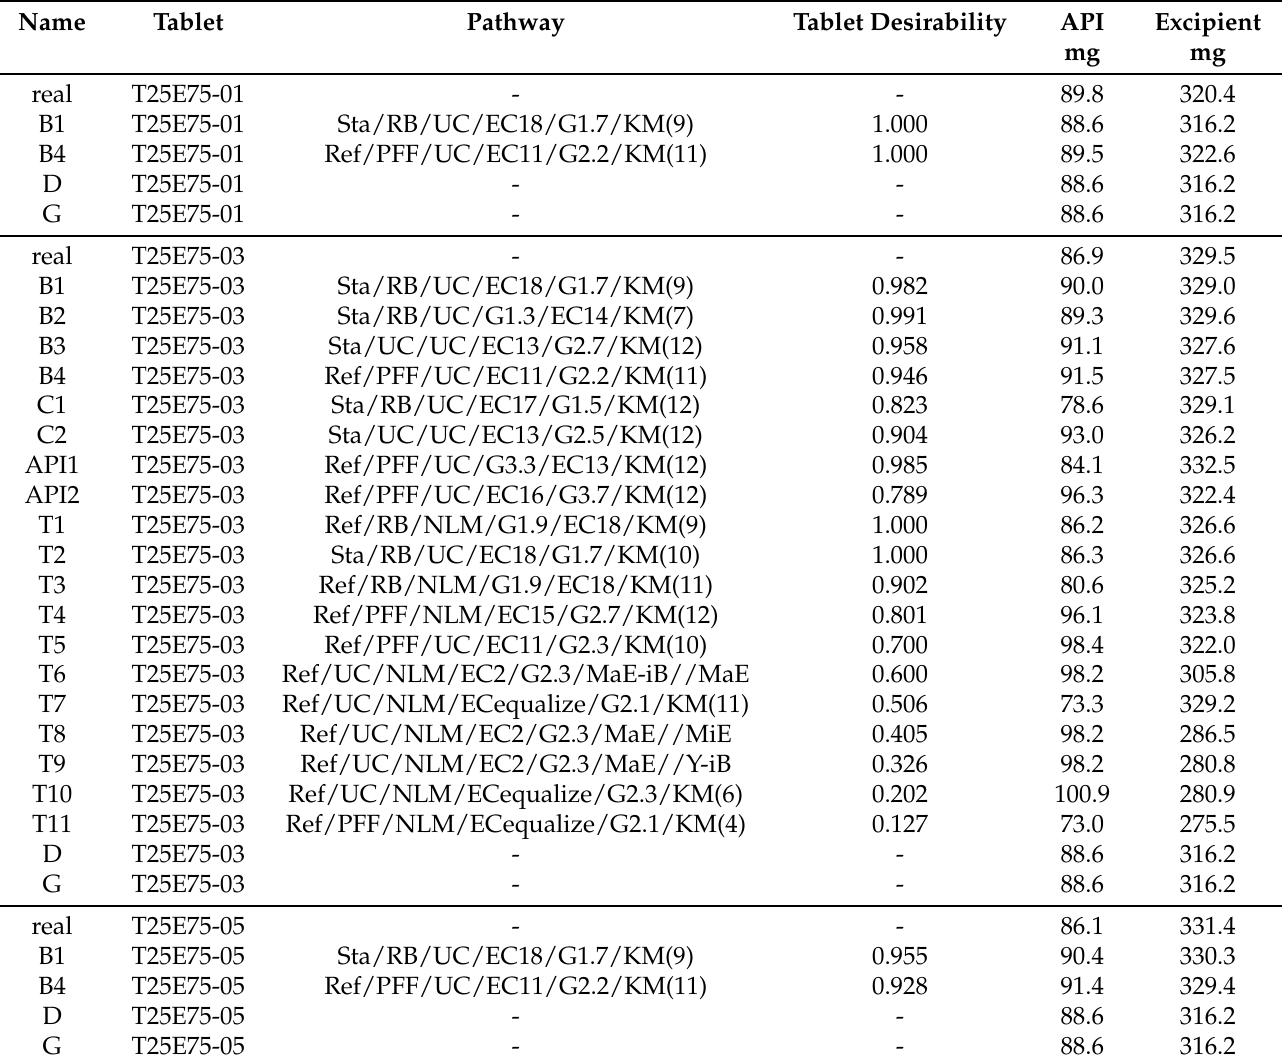
Table 1. The selected images for the in silico calculations. The line called real displays the experimentally determined data of the real